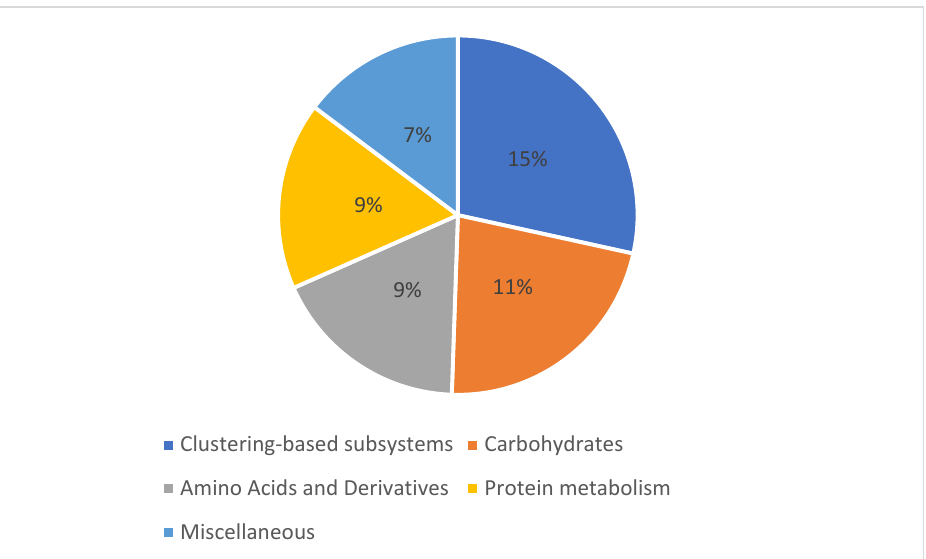
Figure 9. Functional category hits distribution annotated using MG-RAST Subsystems classification in Oualidia lagoon (OSD91).